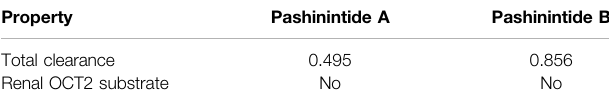
TABLE 7 | Excretion properties of the Pashinintides A and B. Property